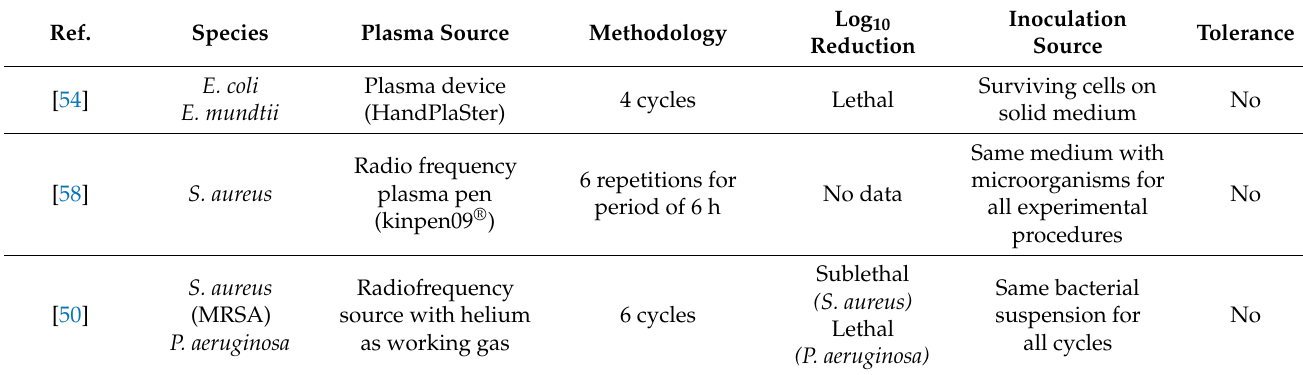
Table 2. Cold atmospheric plasma